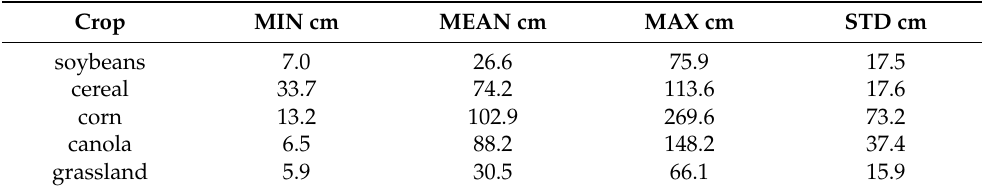
Table 3. Statistical parameters for the minimum (MIN), mean (MEAN), maximum (MAX) and standard deviation (STD) of the height of